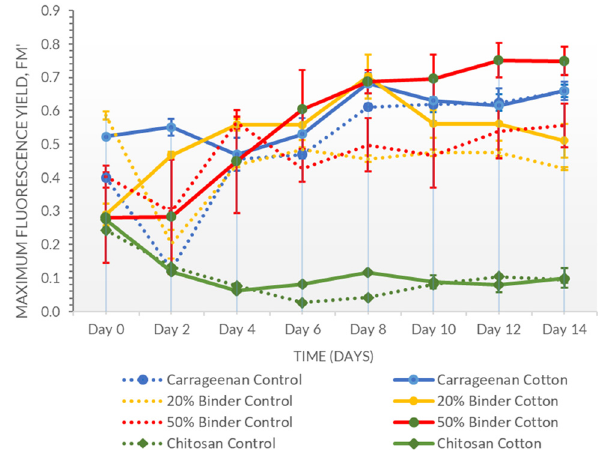
Figure 6: Open incubation of carrageenan cotton ( mean StDev = 0.038 ) and control ( mean StDev = 0.014 ) , 20% binder cotton ( mean StDev = 0.039 ) and control ( mean StDev = 0.013 ) , 50% binder cotton ( mean StDev = 0.098 ) and control ( mean StDev = 0.022 ) , chitosan cotton ( mean StDev = 0.012 ) and control ( mean StDev = 0.006 )